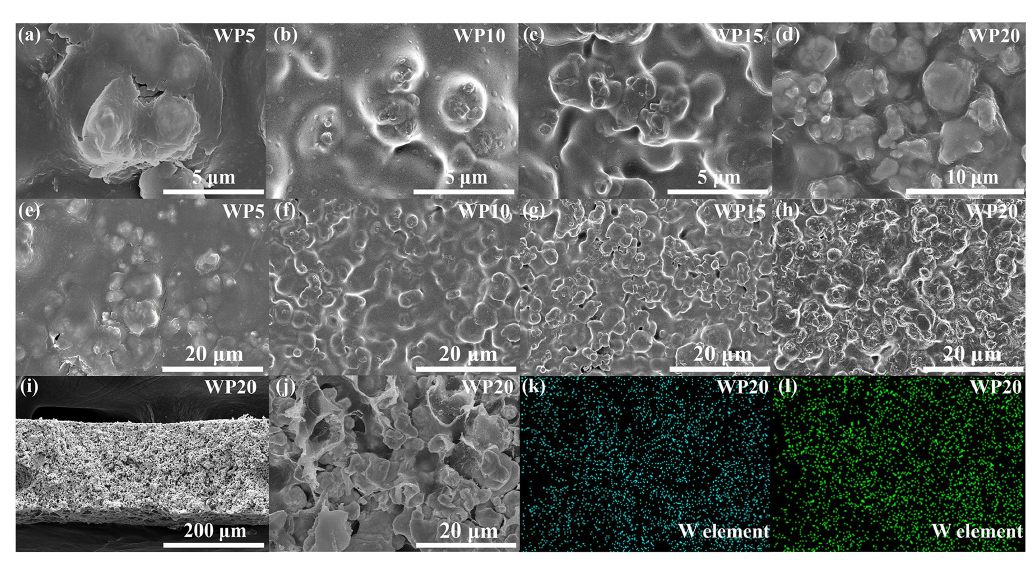
Figure 2. SEM images of WP5 ( a , e ), WP10 ( b , f ), WP15 ( c , g ), and WP20 ( d , h ), fracture surface of WP20 ( i , j ). ( k , l ) are the corresponding SEM ‐ EDS mapping (W element) images of the panel ( j , d ), respectively.